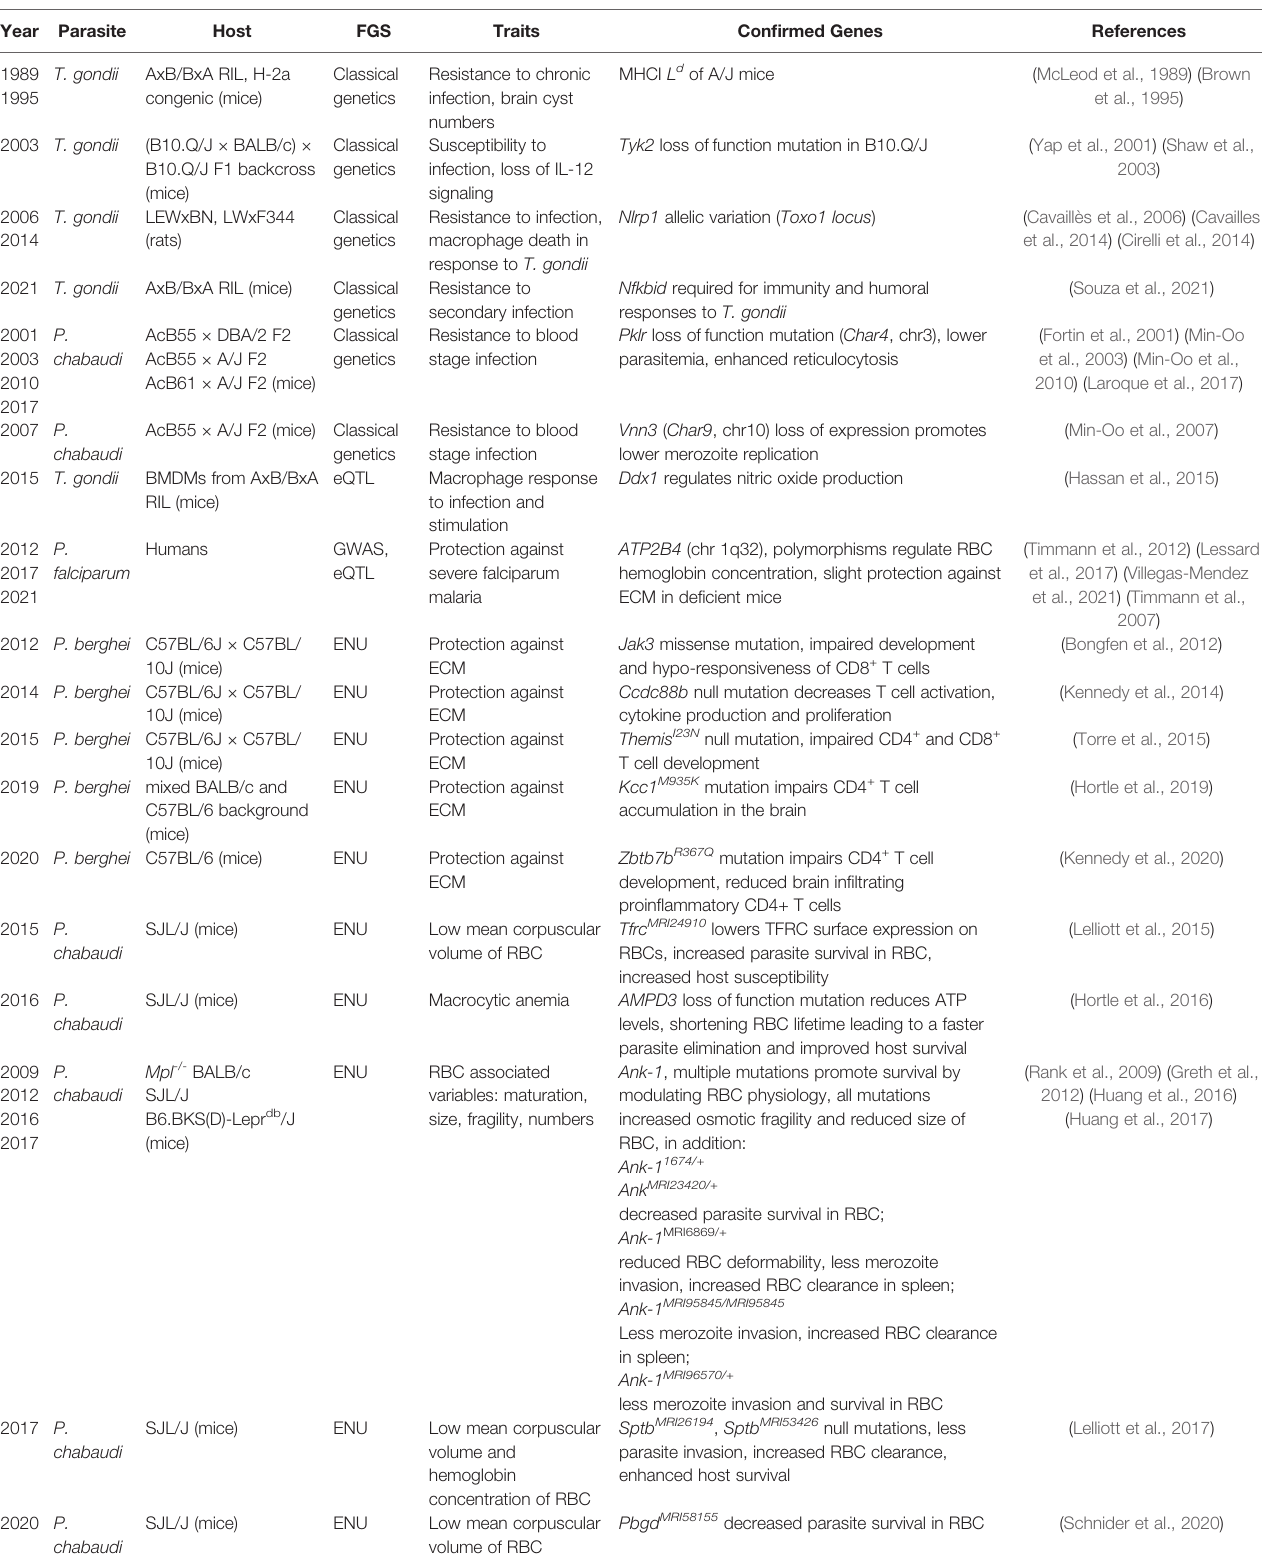
TABLE 1 | Host genes revealed by forward genetic screens analyzing Apicomplexa